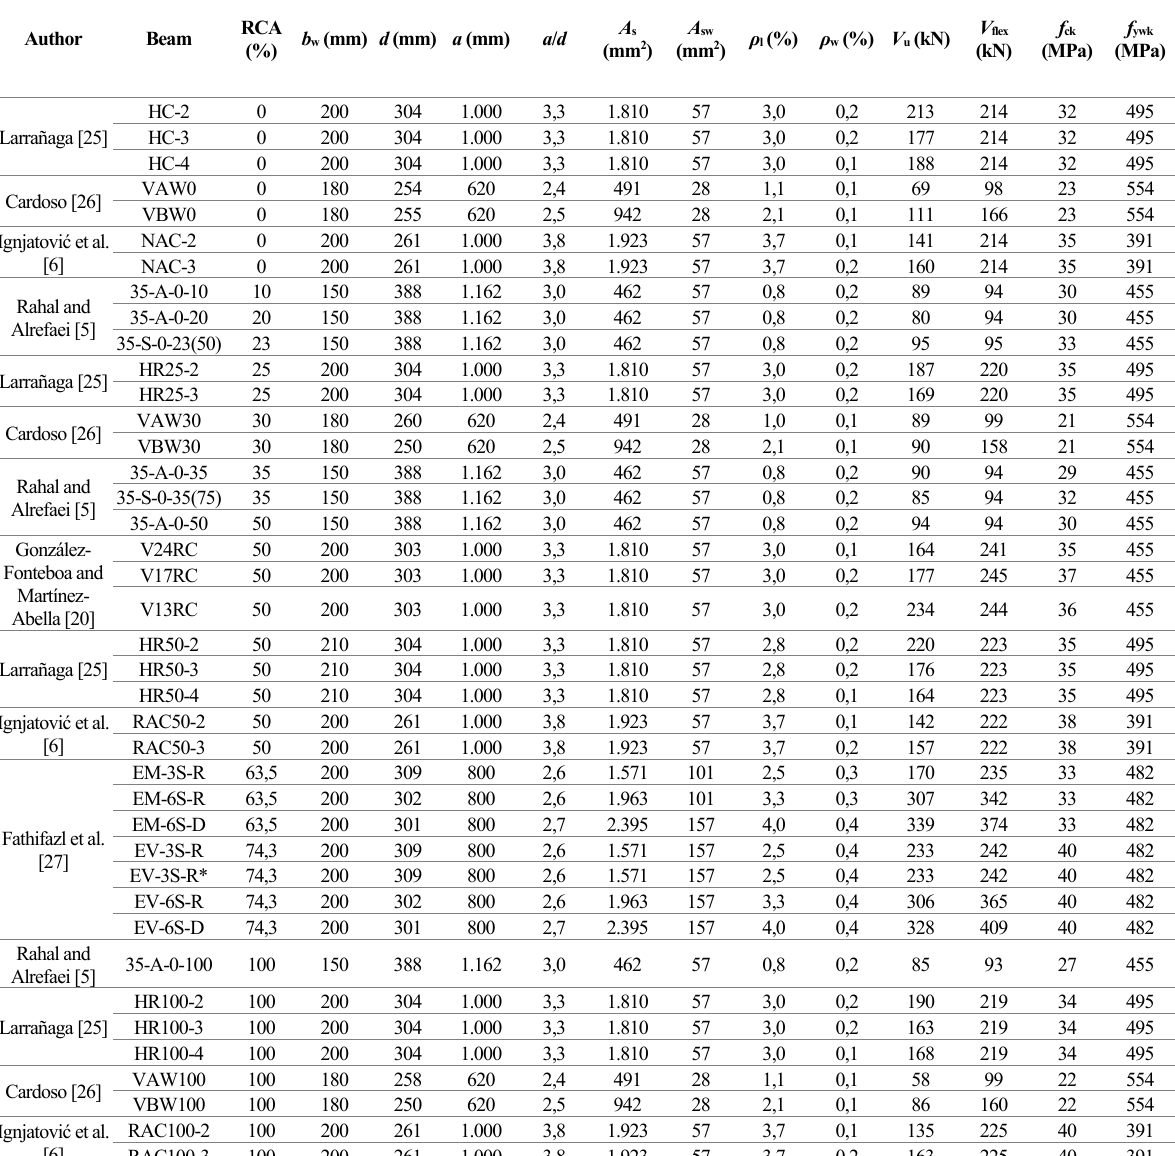
Table A1. Database of tests on reinforced concrete beams with shear